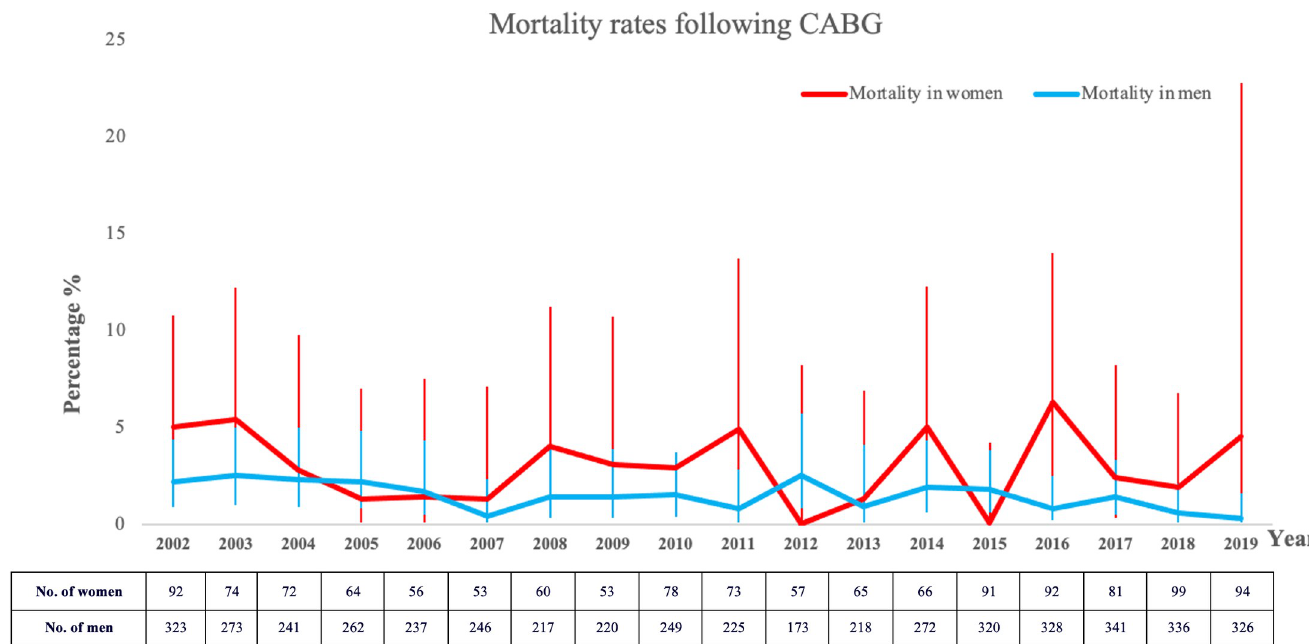
Fig 3. Morbidity ( � 1 post-operative complication) rates following CABG in male and female patients.